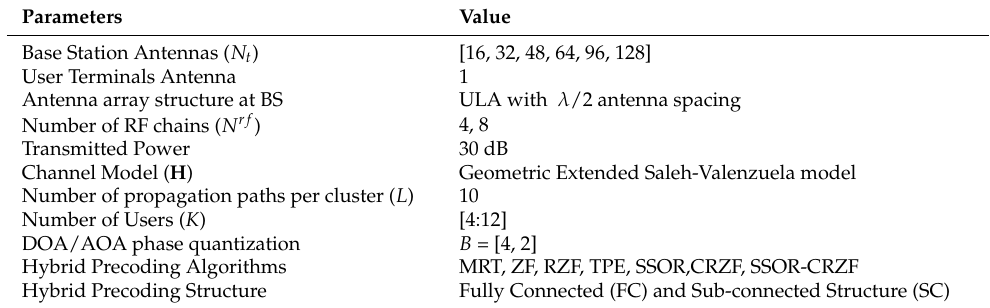
Table 4. Simulation